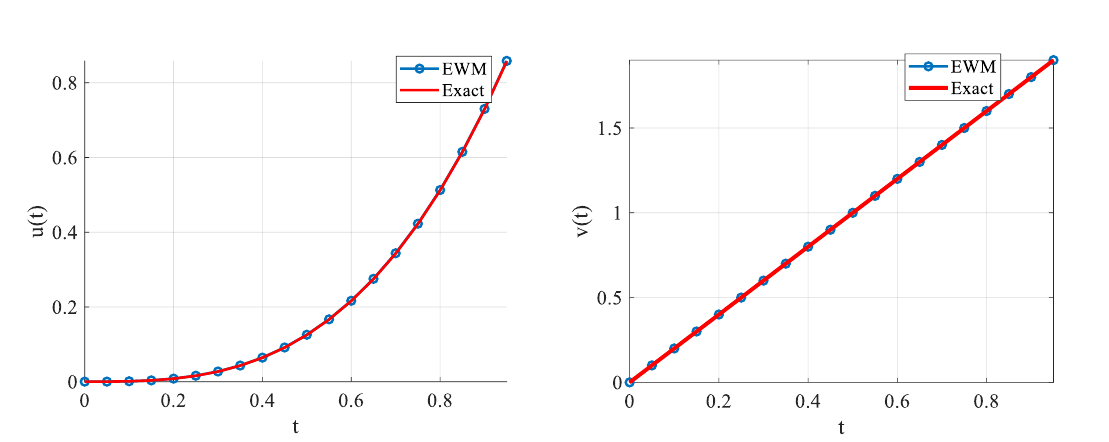
Figure 1. Numerical and exact solutions of u ( t ) and v ( t ) for α = 1, β = 1 for example, 1 ( m (cid:48) = 12).